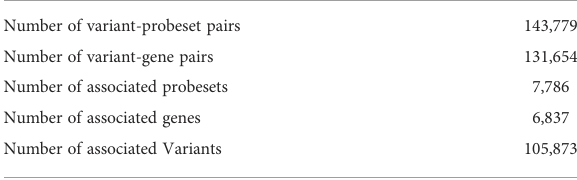
TABLE 2 Discovery of cis-eQTLs a (FDR<0.1) in blood from Chlamydia trachomatis- exposed